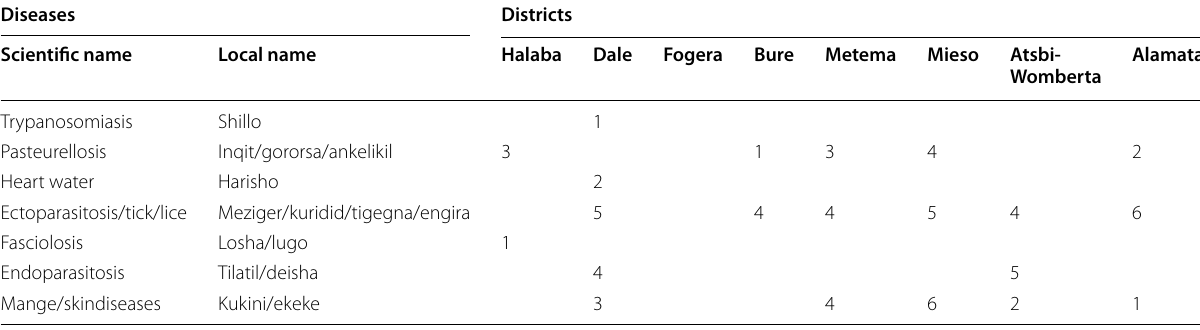
Table 4 Major goat diseases that hamper goat productivity improvement in different parts of Ethiopia in order of importance as expressed by farmers. Sources : Tesfaye